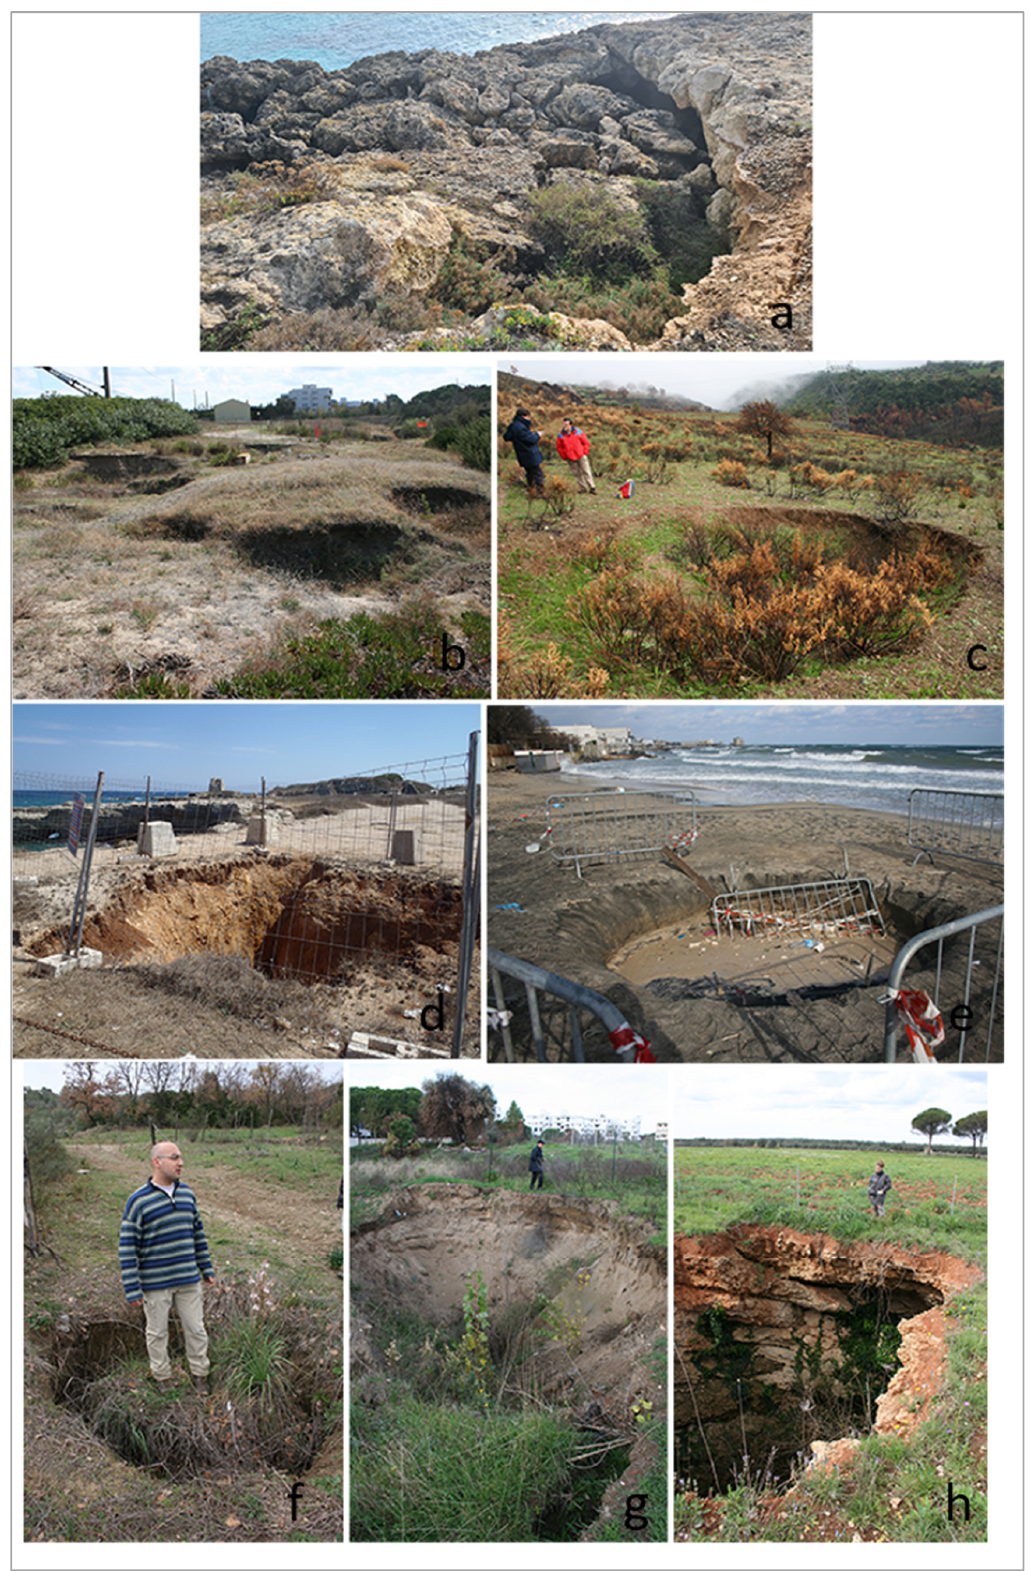
Figure 1. Examples of natural sinkholes from Apulia and Calabria. The sinkholes involve carbonates ( a , d , e , h ), evaporites ( b , f , g ) and alluvial deposits ( c ) and belong to the categories of collapse ( a , d , h ), cover-collapse ( f , g ) and suffusion sinkholes ( b , c , e ).